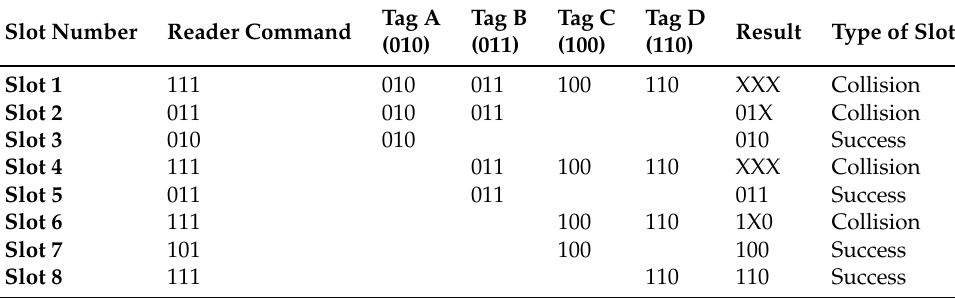
Table 3. Example of the BS